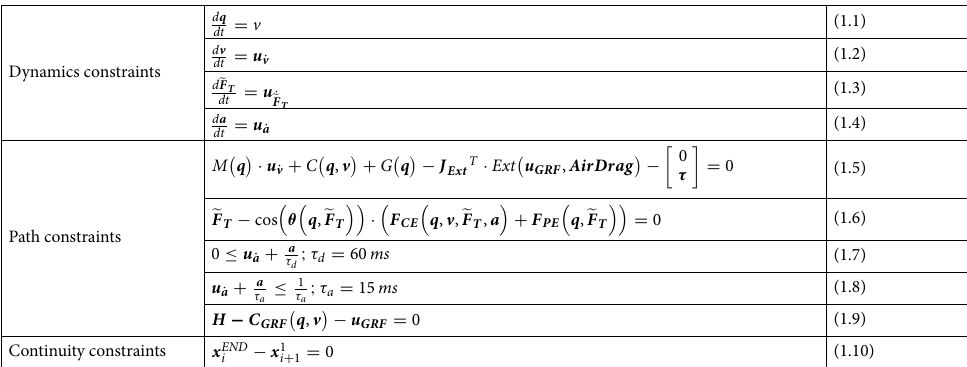
Table 1. Overview of the musculoskeletal model’s constraints. Skeletal dynamics were enforced as per equation ( 1.5 ) , where M is the mass matrix, C is the vector of centrifugal forces, G is the vector of T gravitational forces, J Ext is the transpose of the external forces Jacobian matrix, Ext u GRF , AirDrag is the vector of external ground reaction and air drag forces and τ is the vector of net joint moments (consisting of the moments generated by the MTUs, upper-limb and reserve actuators, and springs attached to the MTP DOFs). Contraction dynamics were imposed using the Hill model equilibrium condition ( 1.6 ) , where the normalised tendon force must equal the projected sum of the normalised contractile F CE and muscle forces. Activation dynamics were enforced using the inequality constraint equations ( 1.7 − 1.8 ) , and they were derived from the original differential equation describing activation dynamics 30 . Equation ( 1.9 ) was imposed to ensure consistency between the ground reaction forces calculated from the contact model H − C GRF and the controls u GRF .